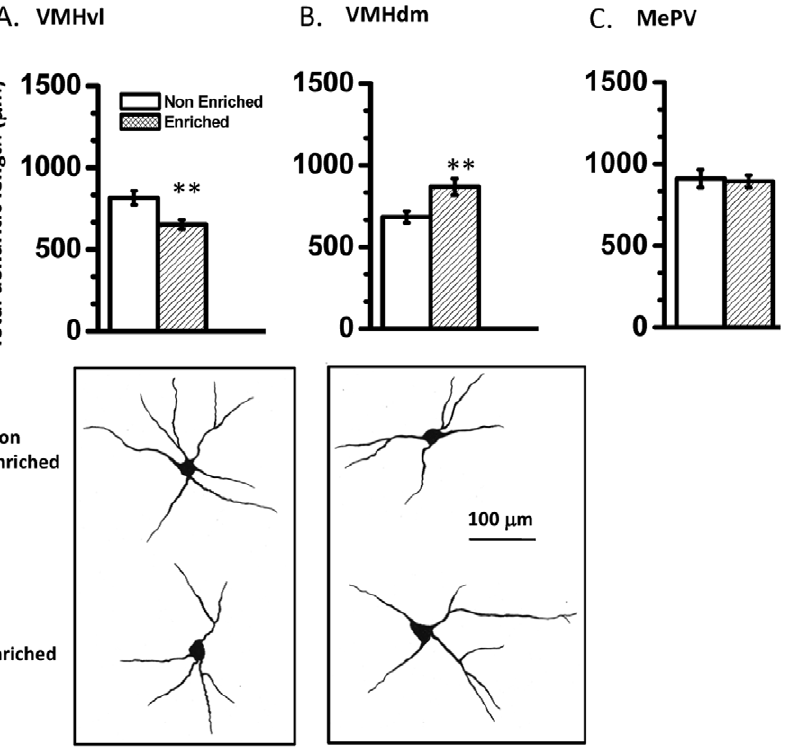
Figure 5. Enriched males show neuronal plasticity in hypothalamus. Enriched animals show significantly reduced dendritic length of neurons from VMHvl compared to non-enriched animals (A). Enriched animals show significantly enhanced dendritic length of neurons from VMHdm compared to non-enriched animals (B). Representative neuronal tracings from VMHvl (left) and VMHdm (right) for non-enriched (upper panel) and enriched (lower panel) animals. Scale bar is 100 m m. ( Inset ). Enriched and non-enriched animals show similar dendritic length of neurons from postero-ventral part of medial amygdala MePV (C). ** p , 0.01, exact Mann-Whitney test; n=30–40 neurons per group.